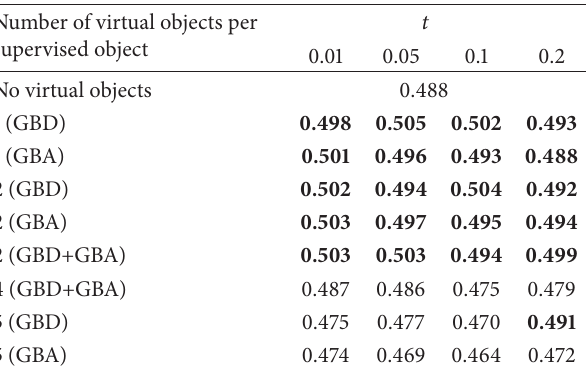
Table 5: Comparison of recognition rates with and without virtual objects ( CiteSeer